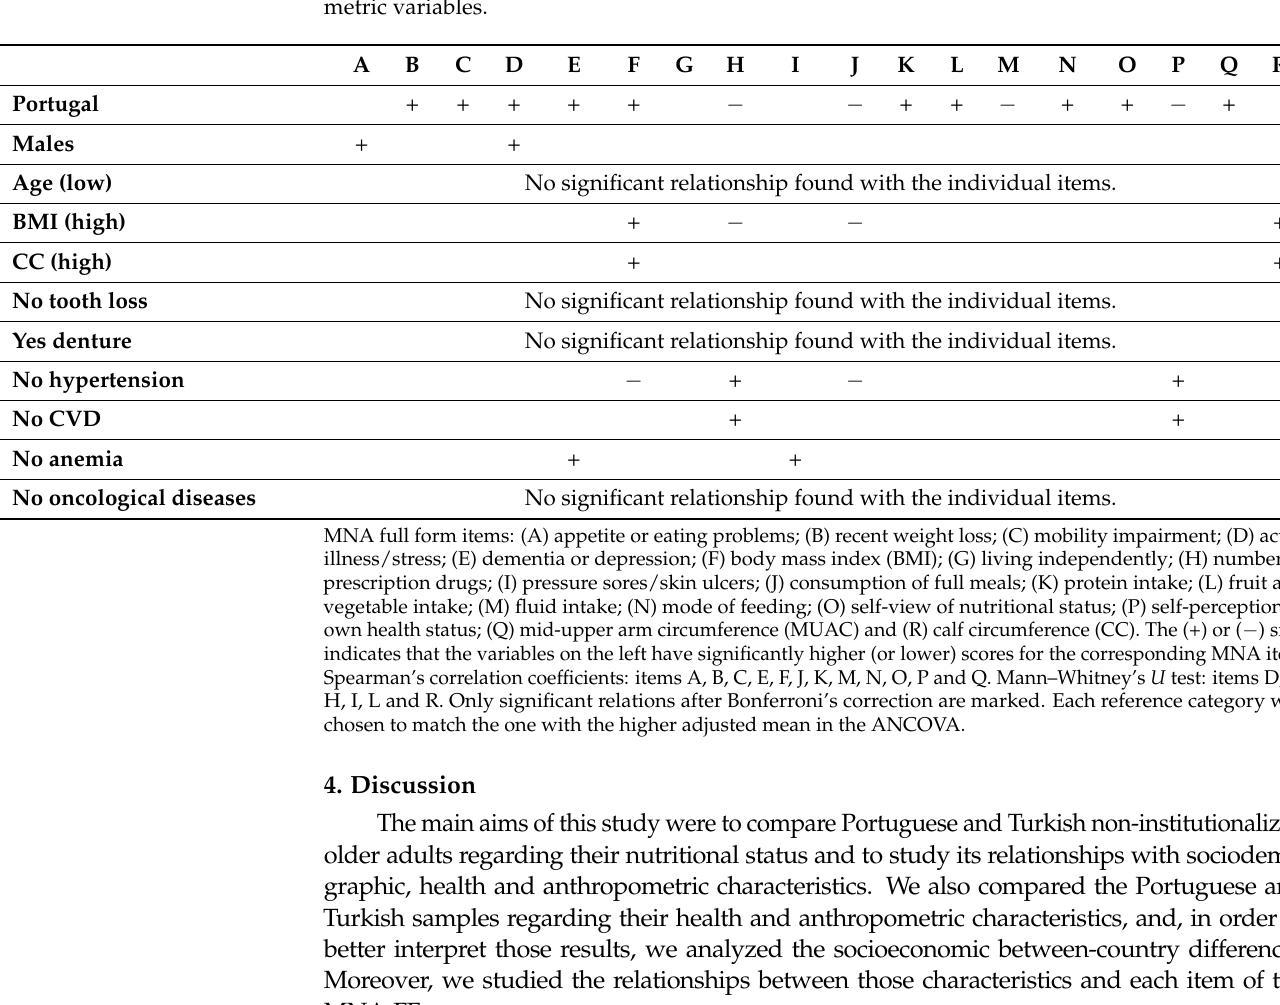
Table 5. Relationship of each MNA full form item with the sociodemographic, health and anthropo- metric